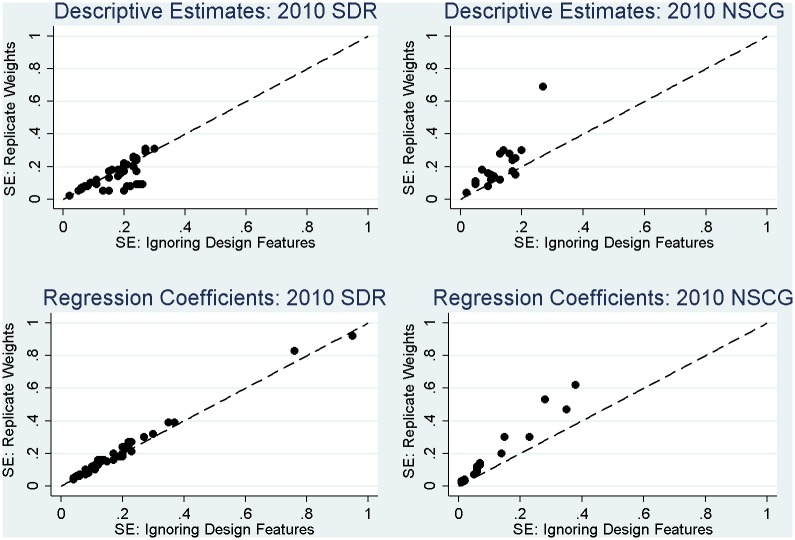
Correspondence between estimated standard errors (SE) for the 2010 SDR and 2010 NSCG estimates based on the replicate weights, which fully account for the complex sampling features, and standard errors based on ignoring the complex sampling features entirely (including a dashed 45-degree line representing perfect correspondence).